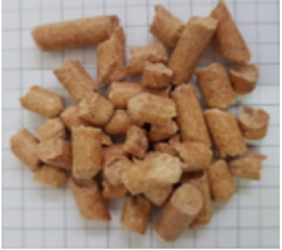
Figure 1. Barley straw